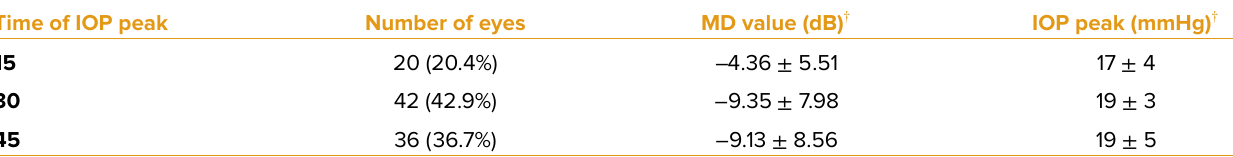
Table 2. Distribution of number of eyes, mean MD, and mean IOP peak value of eyes according to the time of IOP peak in the WDT